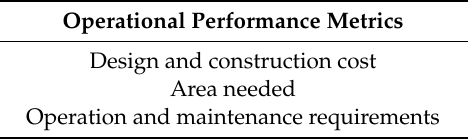
Table 3. Operational performance metrics for supply augmentation e ff orts